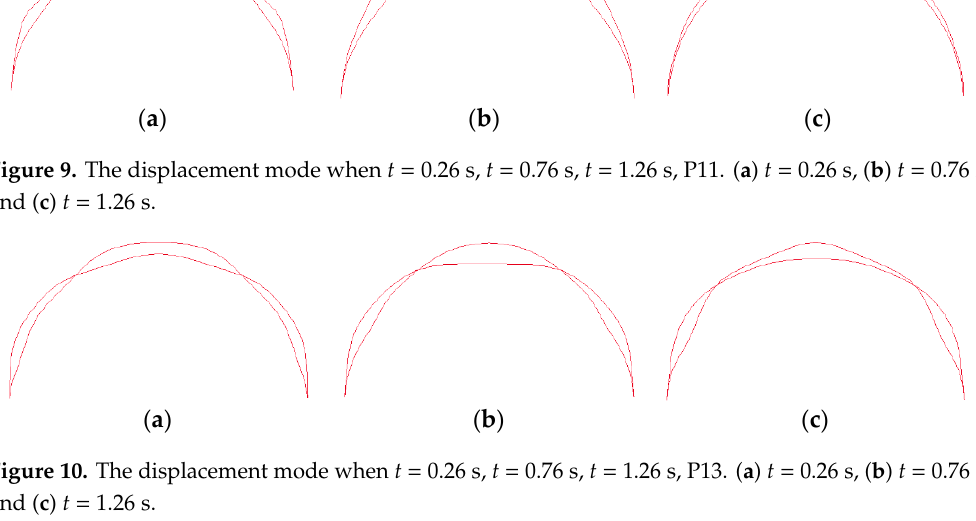
Figure 10. The displacement mode when t = 0.26 s, t = 0.76 s, t = 1.26 s, P13. ( a ) t = 0.26 s, ( b ) t = 0.76 s, and ( c ) t = 1.26 s.